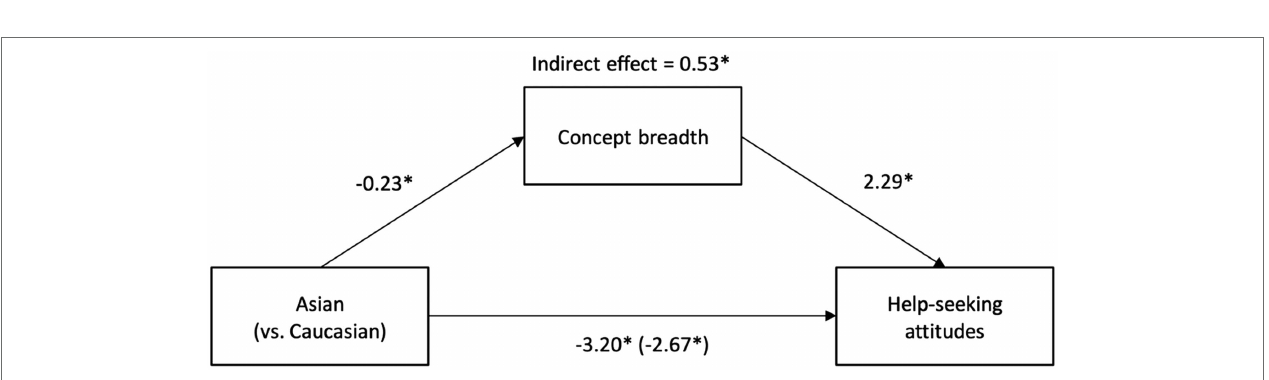
FIGURE 2 | Mediation model with concept breadth as the mediator. Unstandardized regression coefficients for the relationship between group (Asian American: n = 102; White American: n = 110) and help-seeking attitudes as mediated by concept breadth. The unstandardized regression coefficient between group and help-seeking attitudes controlling for concept breadth is in parentheses. Indirect effect of concept breadth on the relationship from bootstrap analyses ( n = 10,000). * p <